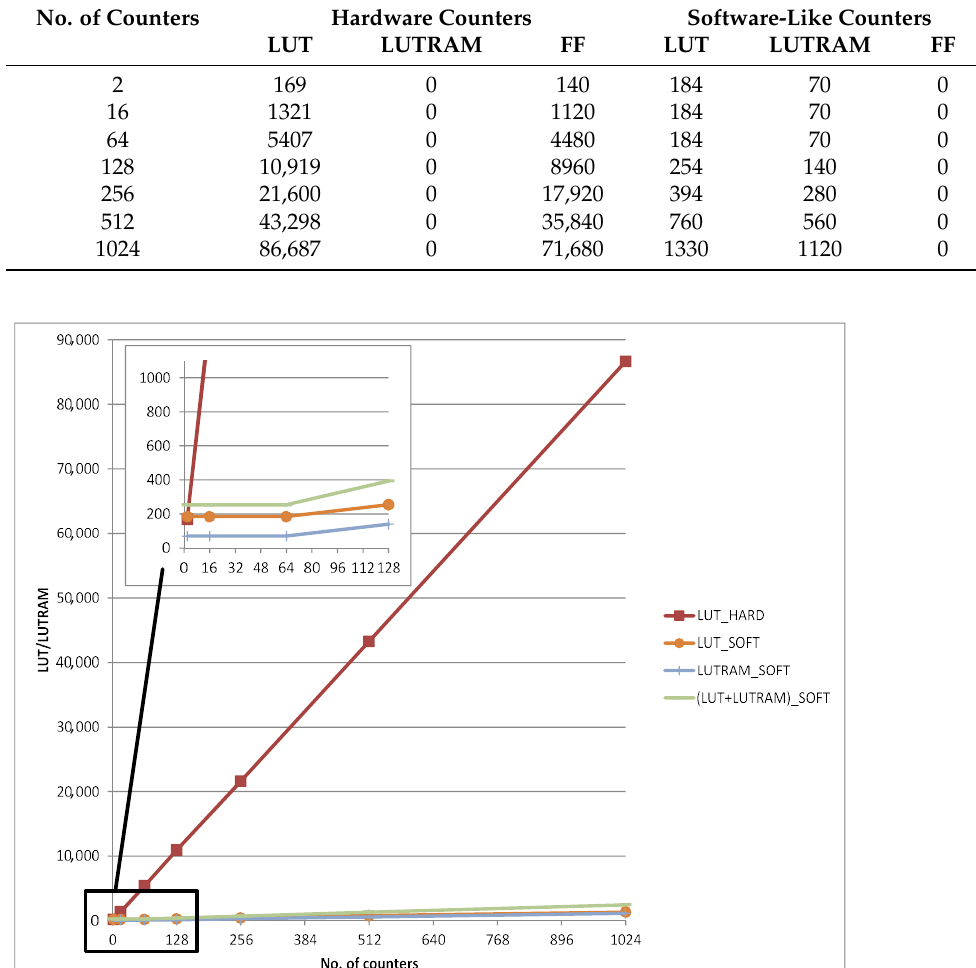
Table 1. The comparison of the logic utilization for hardware and software-like counters.